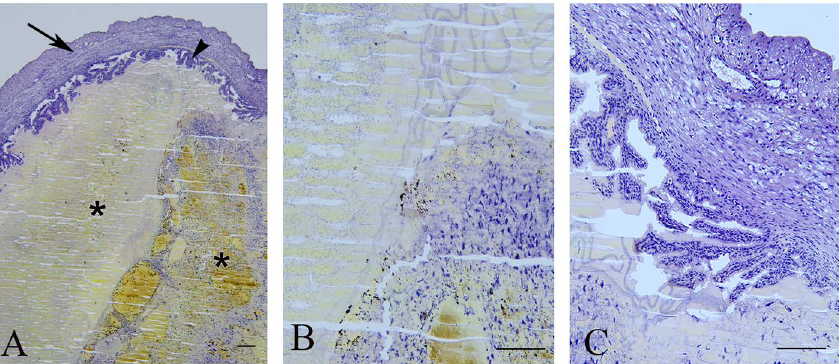
Figure 2. Late miscarriage. ( A )—Uterus (arrow) with undeveloped fetuses (asterisks) and chorion villi (arrowhead) border arrows); bar = 200 µ m. ( B )—Detail of the remnants of the fetus; bar = 100 µ m. ( C )—Branched chorionic villi; bar = 100 µ m.